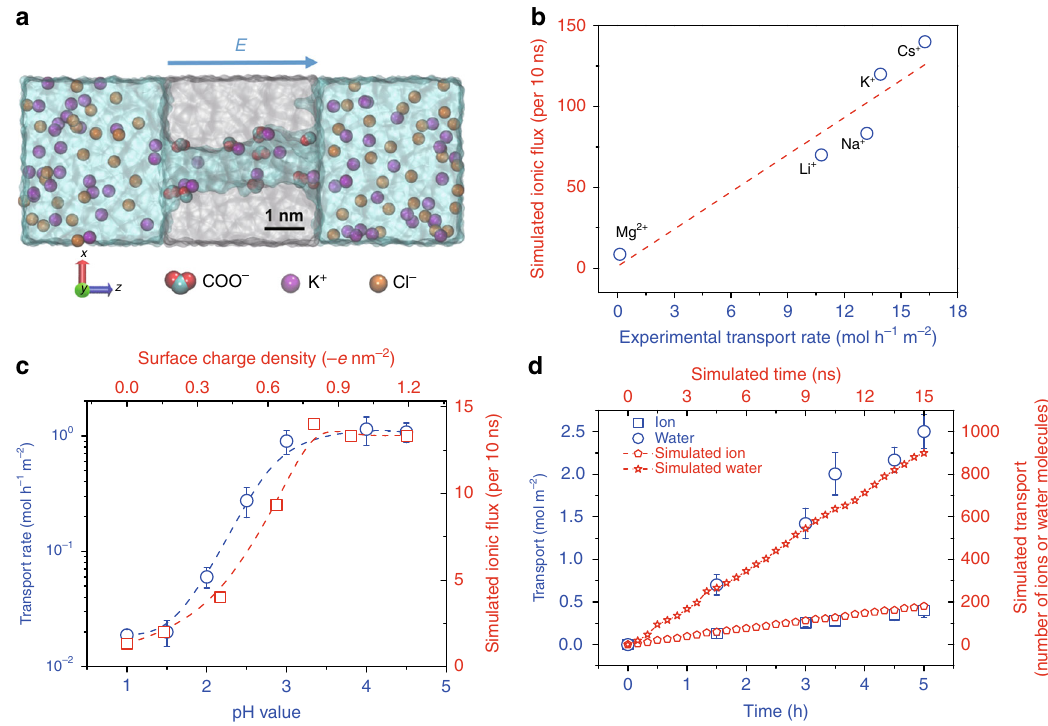
Fig. 2 MD simulations and transport measurements. a Cross-sectional scheme of polymeric nanopore model with 1 M KCl electrolyte solution on both membrane sides. The polymer matrix material is shown in gray; negatively charged residues (COO − ) are shown in red (O) and cyan (C); K + and Cl − ions are shown in purple and yellow, respectively. For all simulations without speci fi cation, a voltage of 1.2 V is applied along the pore axis, i.e., z direction. b Simulated vs. experimental transport rates for various ions. The red dashed line is a linear fi t to the data (blue circles) ( R 2 = 0.88). c Experimental (circles) and simulated (squares) transport rates of K + ions as a function of pH (blue) and surface charge density (red), respectively. Error bars represent the standard deviation of three measurements. The average transport rate of K + ions through the PET Lumirror® fi lms was measured with a feed solution of KCl (1 M) and an applied voltage of 5 V. A voltage of 0.12 V is applied across the pore in the simulation. The blue and red dashed lines are fi ts to the experimental and simulation data, respectively. d Comparison of simulated and experimental transport number of ions or water molecules. Water and ion transport through the PET Lumirror® fi lm from the feed chamber with a 0.01 M KCl solution and an applied voltage of 10 V in the experiment. Dashed lines are linear fi